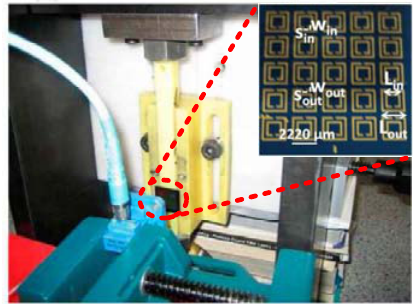
Figure 11. Fabricated 5 × 5 SRR array-based strain sensor under test in the compression apparatus